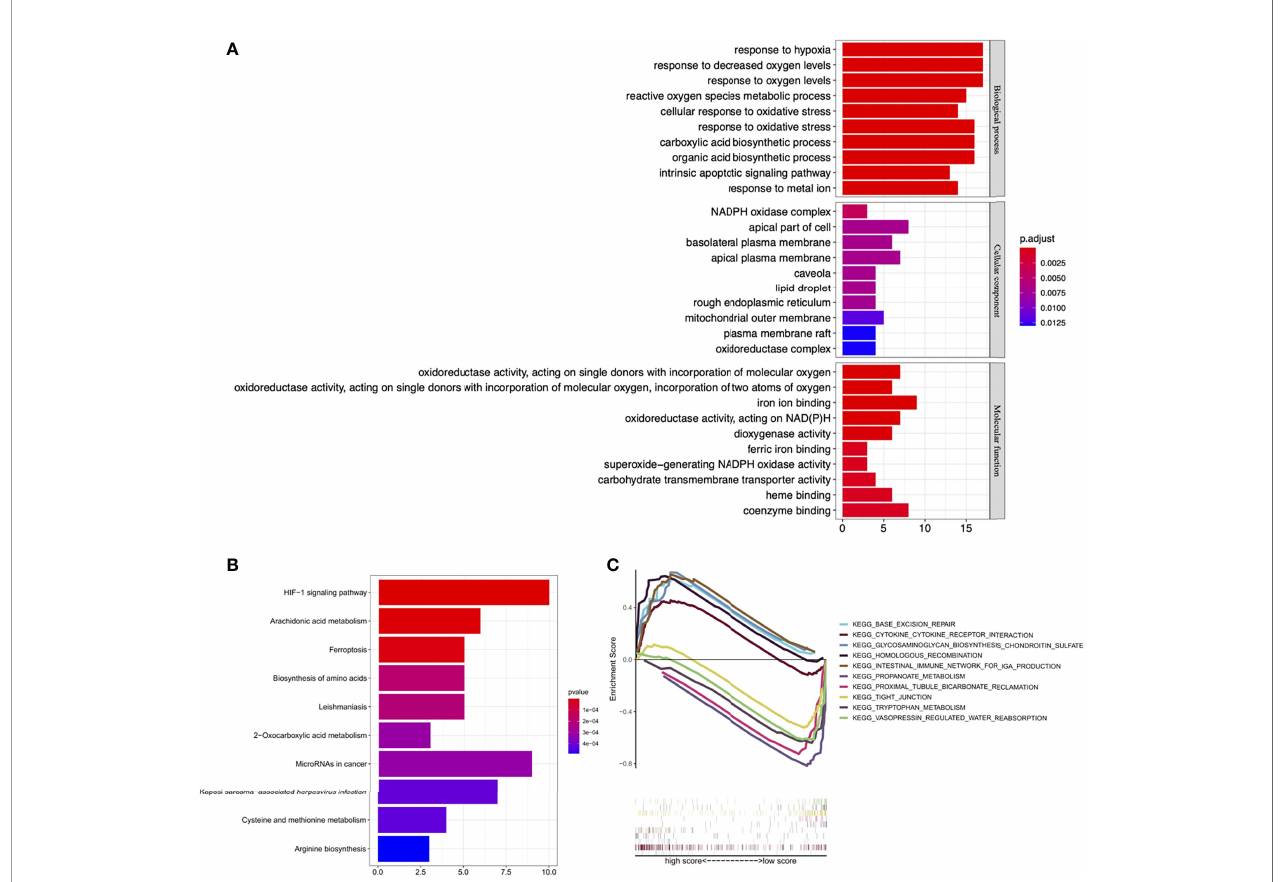
FIGURE 13 | Functional enrichment analysis. (A) GO enrichment analysis of the DE-FRGs. (B) KEGG enrichment analysis of the DE-FRGs. (C) GSEA plot for signi fi cant enriched biological processes associated with the four optimal PR-FRGs. GO, gene ontology; KEGG, Kyoto Encyclopedia of Genes and Genomes; GSEA, Gene Set Enrichment Analysis; DE-FRGs, differentially expressed FRGs; PR-FRGs, prognosis-related